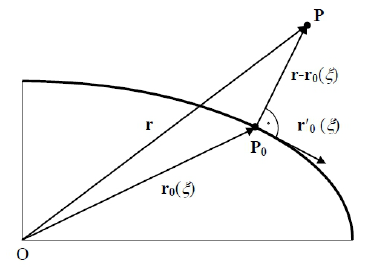
Figure 1. Geometric illustration of the